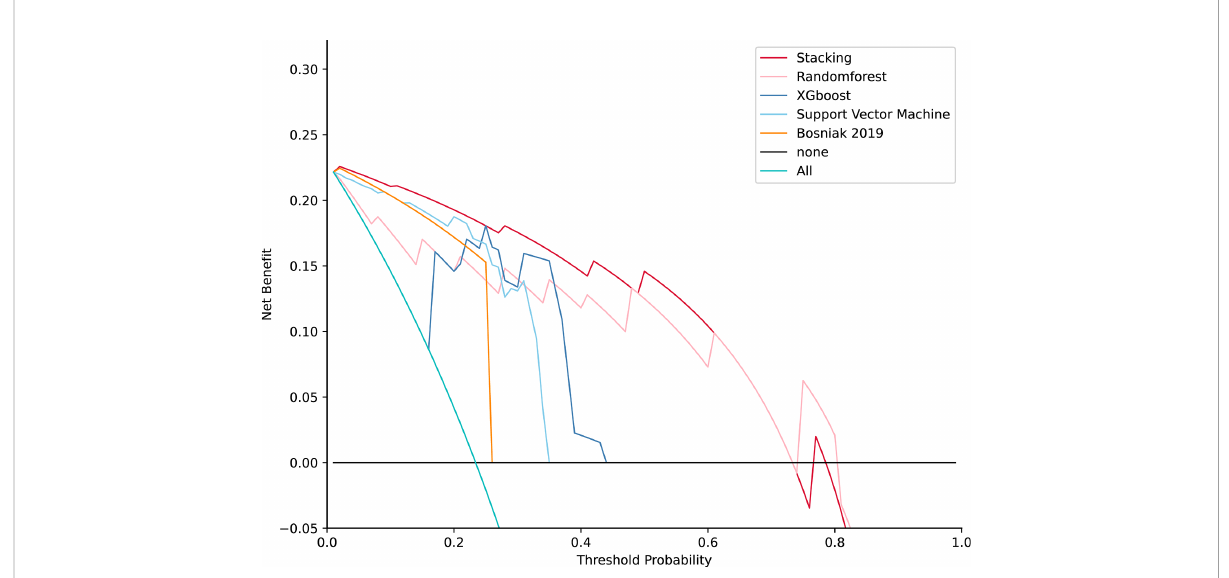
FIGURE 6 Decision curve analysis for four models compared with the Bosniak 2019 version in testing datasets. The net bene fi t is represented on the y -axis and the corresponding threshold probability is represented on the x -axis. The stacking model is represented by the red line. The Bosniak 2019 version is represented by the yellow line. All machine learning models present better performance and offered more net bene fi t than the Bosniak